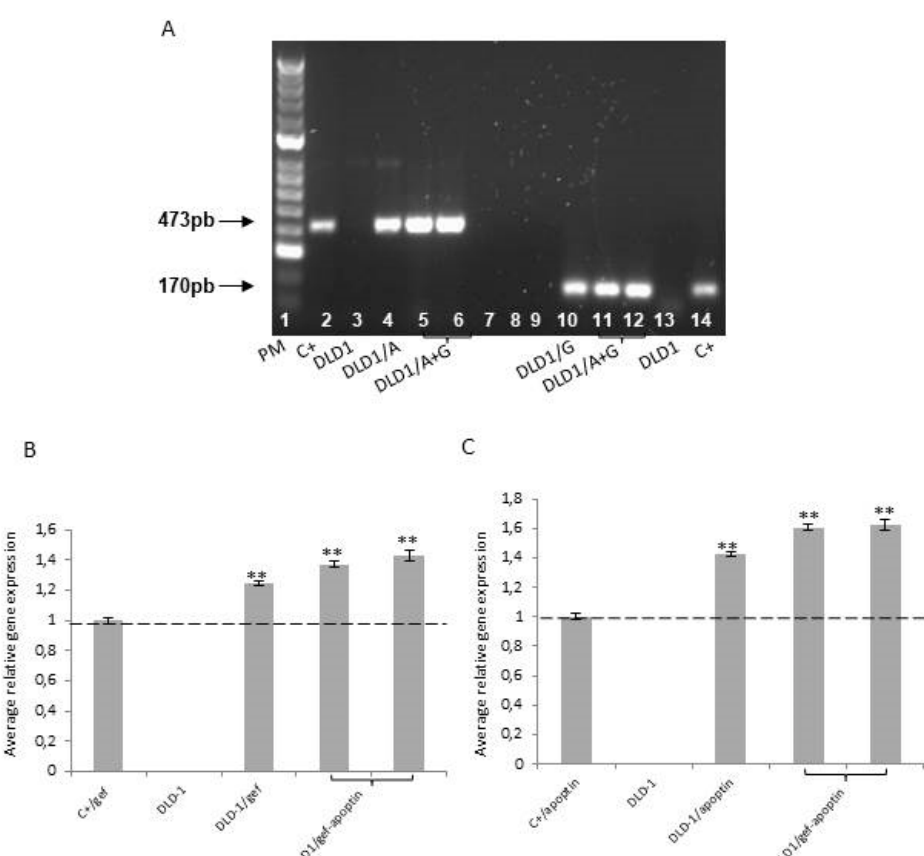
Figure 1. ( A ) RT-PCR analysis shows expression of apoptin and gef genes. Lane 1: hyper ladder II;